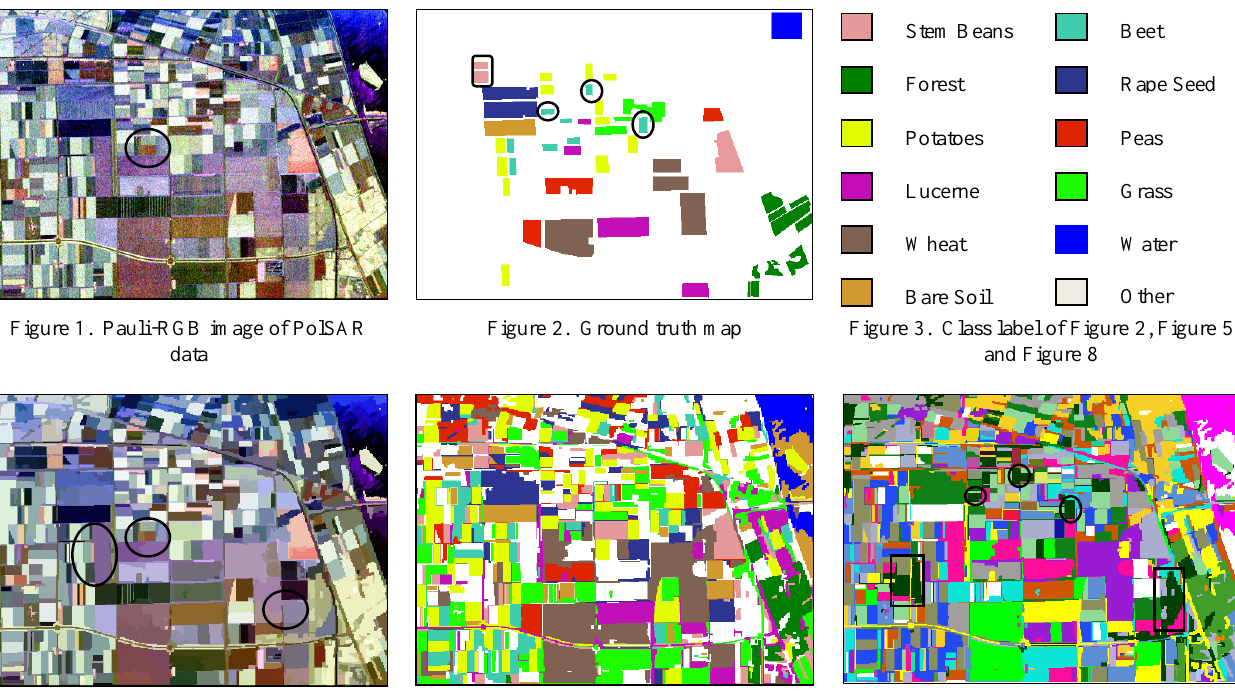
Figure 4. SRM segmentation map Figure 5. Merged classification map of